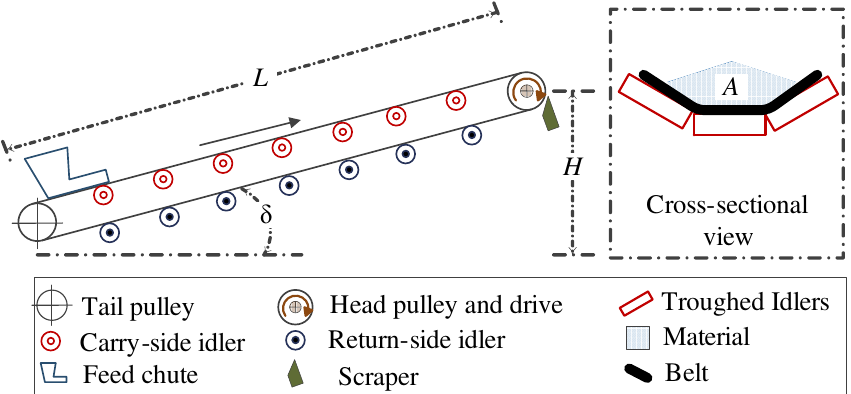
Figure 1. Simplified sketch of a